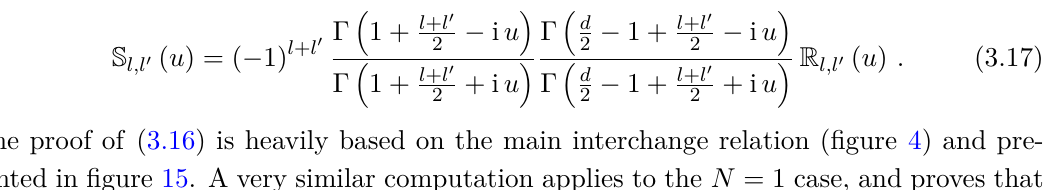
Figure 12 . Left: graphical representation of the layer operator C · Λ 4 ( u 4 ) ∝ C ( ∇ x blue triangle stands for the differential operator C ( ∇ x eigenvector | u 1 , . . . , u 4 ; C i